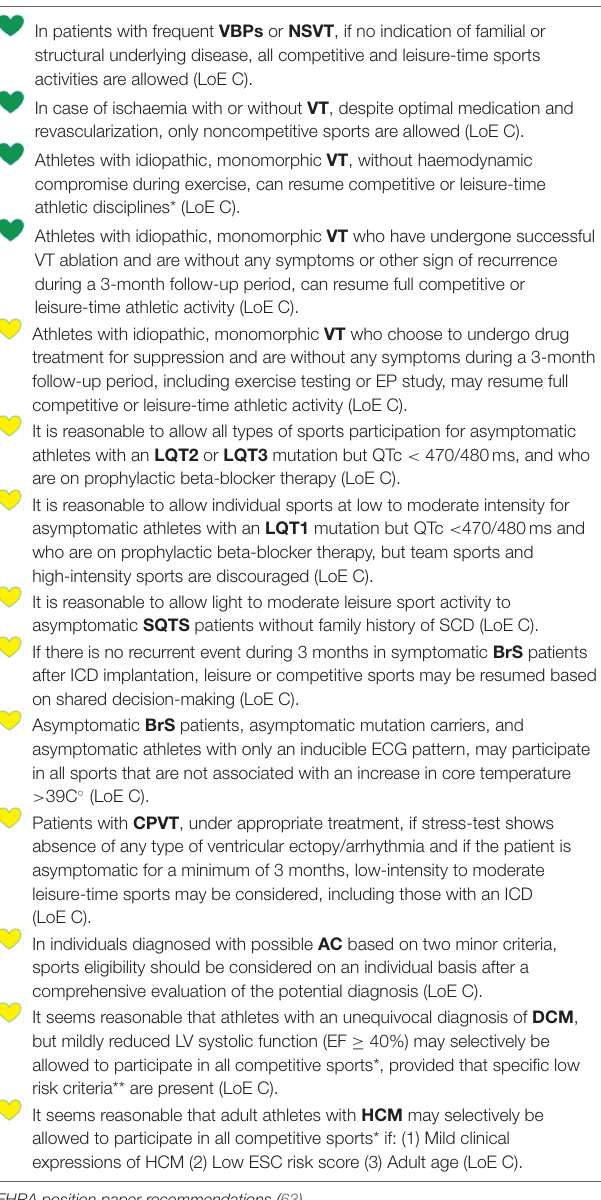
TABLE 3 | Disease-specific recommendation for sports practice in patients with potentially arrhythmogenic conditions. In patients with frequent VBPs or NSVT , if no indication of familial or structural underlying disease, all competitive and leisure-time sports activities are allowed (LoE